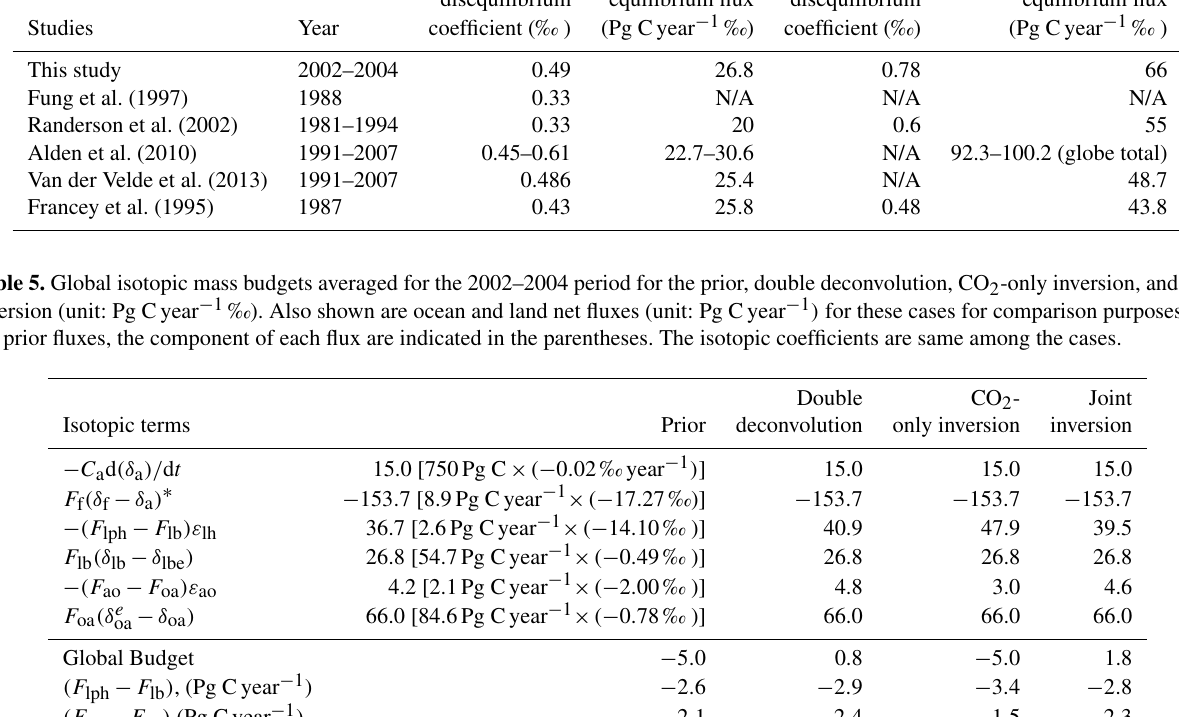
Table 4. Comparison of land and ocean disequilibrium coefficients and disequilibrium fluxes calculated in this study with those in previous studies.